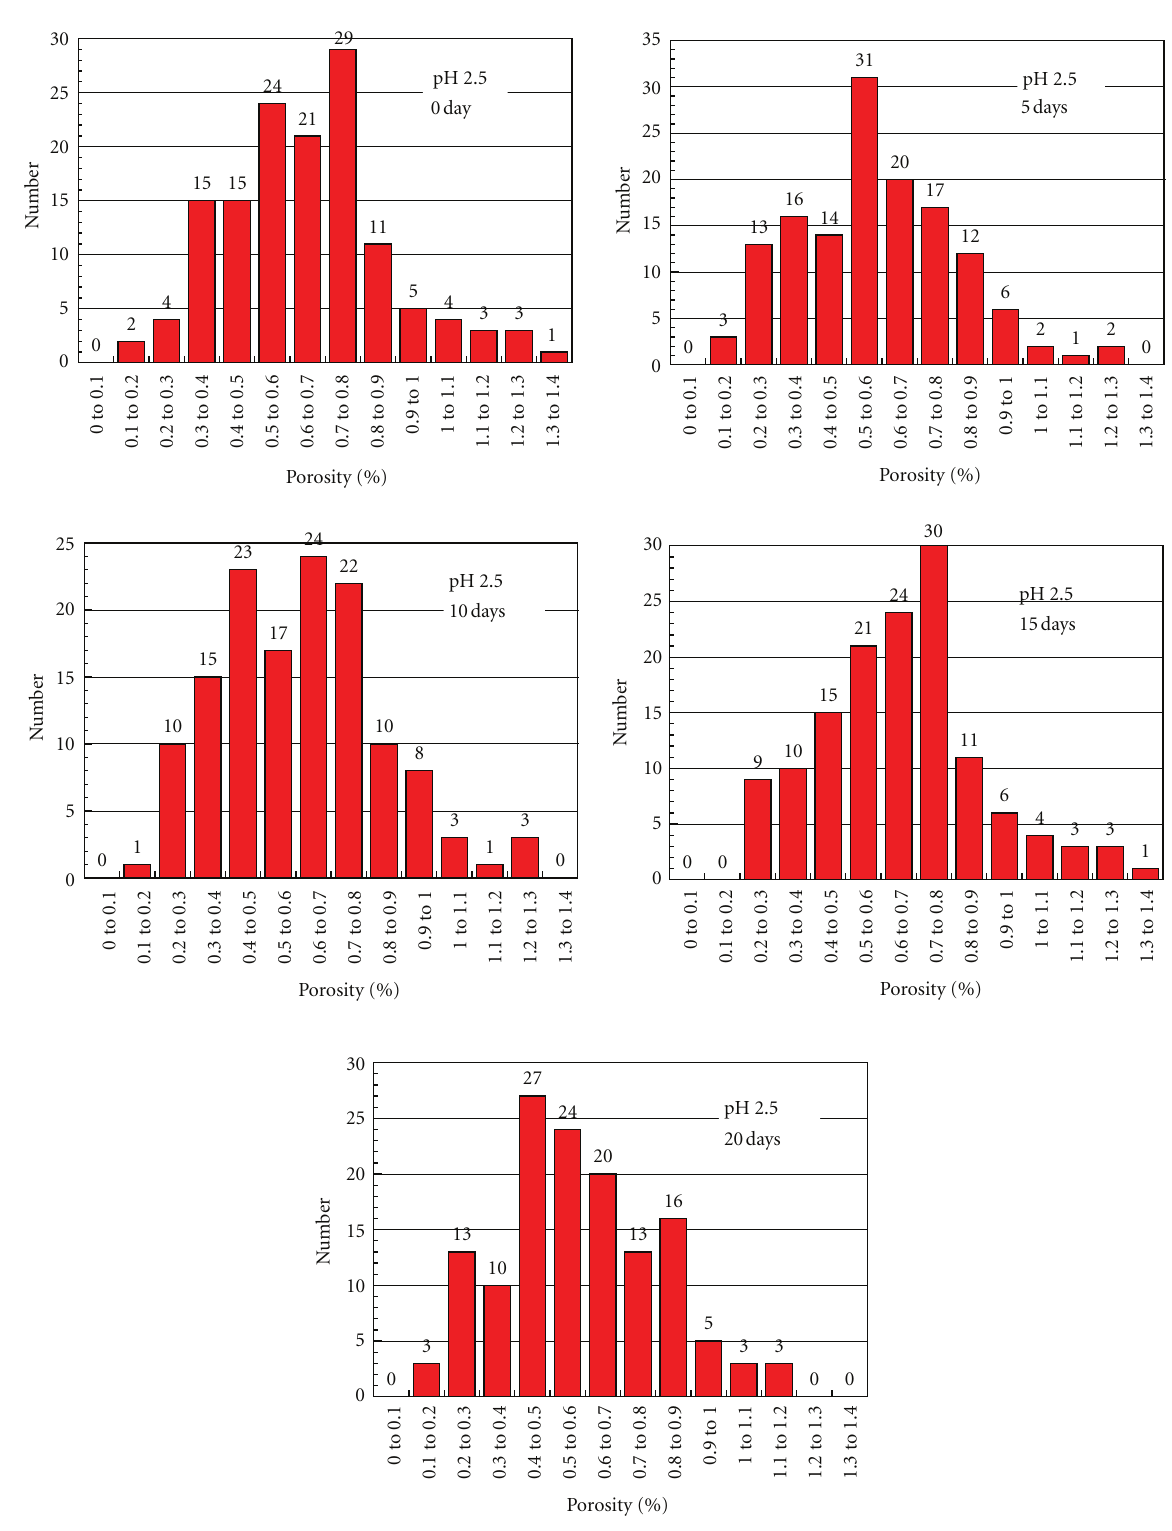
Figure 10: Probability distribution of the porosity inside concrete